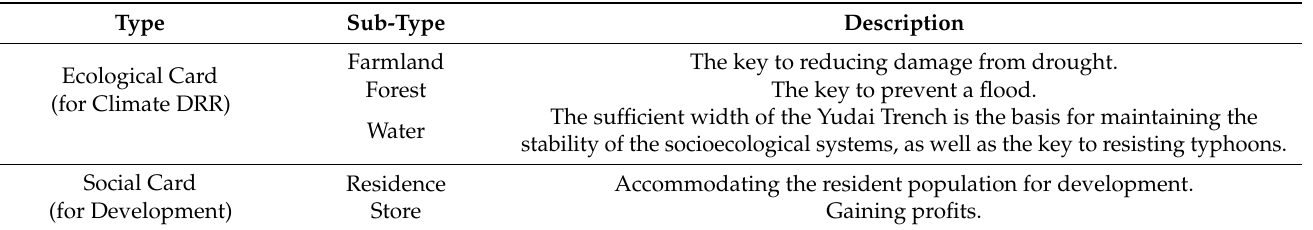
Table 2. The types of cards used for the development and DRR of the Yudai Trench.